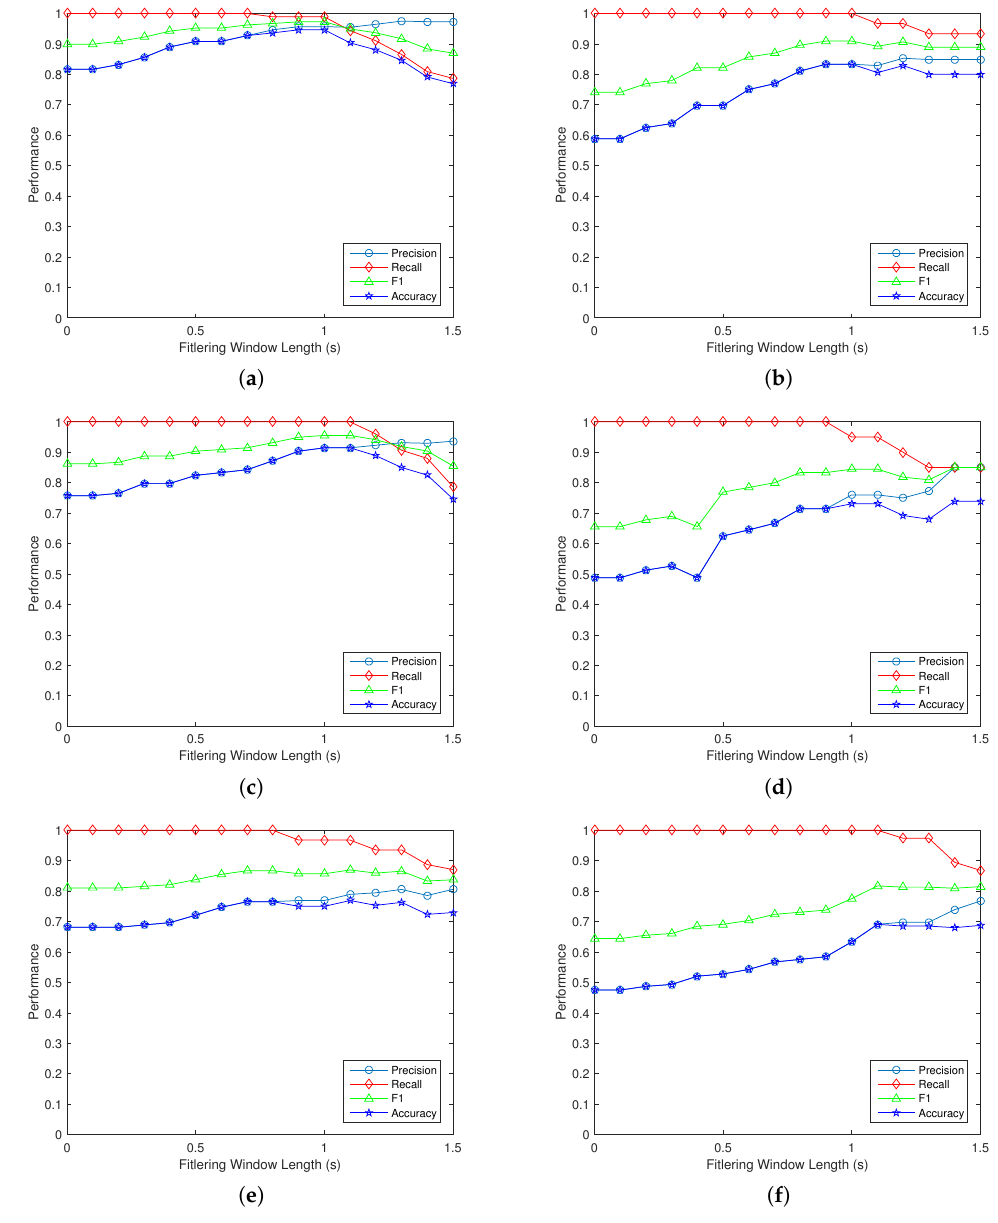
Figure 7. The impact of the time length of the filtering window on prediction performance in Dataset I-80. The left column shows the prediction performance of left lane changes, and the right column shows that of right lane changes. ( a ) Performance of left lane change in Dataset (I); ( b ) Performance of right lane change in Dataset (I); ( c ) Performance of left lane change in Dataset (II); ( d ) Performance of right lane change in Dataset (II); ( e ) Performance of left lane change in Dataset (III); ( f ) Performance of right lane change in Dataset